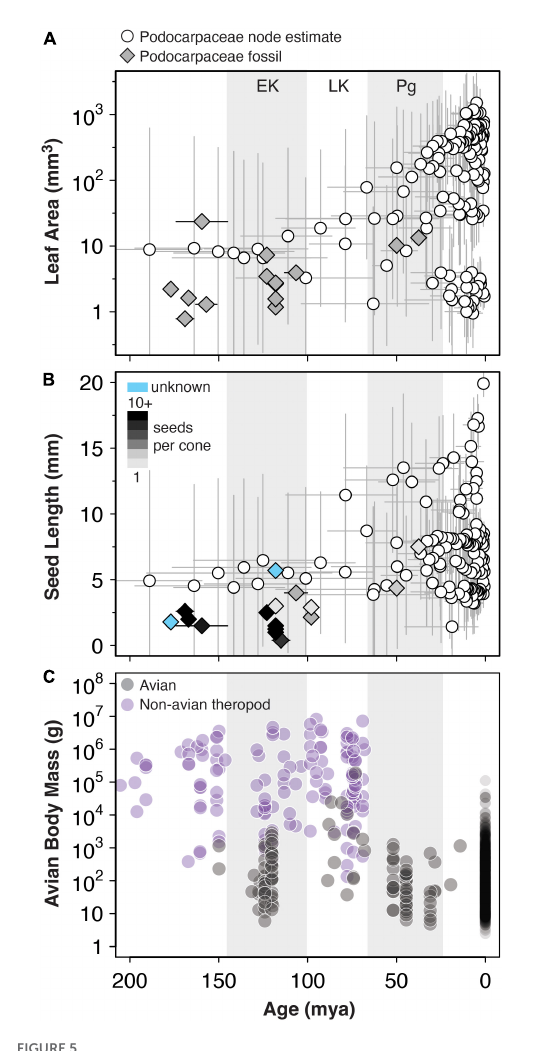
FIGURE5 Ancestral state reconstructions and fossil evidence of continuous traits through time. (A) Estimates of leaf area from fossils (diamonds) and ancestral state reconstructions of internal nodes in a molecular phylogeny based on neontological data (white circles). Node age is shown as the median estimated divergence age. (B) Estimates of seed length from fossil (diamonds) and ancestral state reconstructions using the molecular phylogeny (white circles). Fossil icons are colored according to average number of seeds per reproductive structure; fragmentary structures where total seed number is unknown are indicated by blue. For (A,B) , 95% confidence intervals on node estimates are shown by gray bars. (C) Avian (gray circles) and non-avian theropod (purple circles) body sizes from the Late Jurassic to the recent; data from Benson et al. (2014,